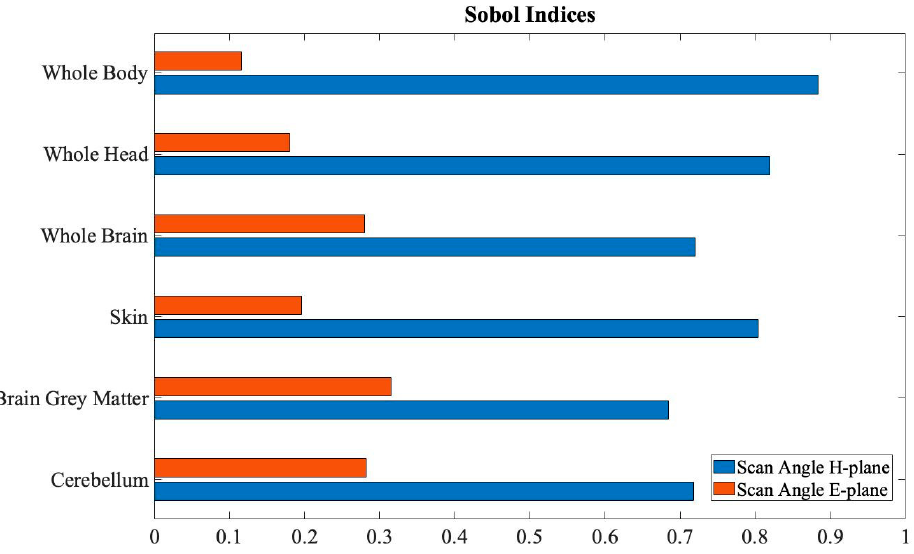
Figure 8. The normalized Sobol indices for the six SAR distributions under investigation.